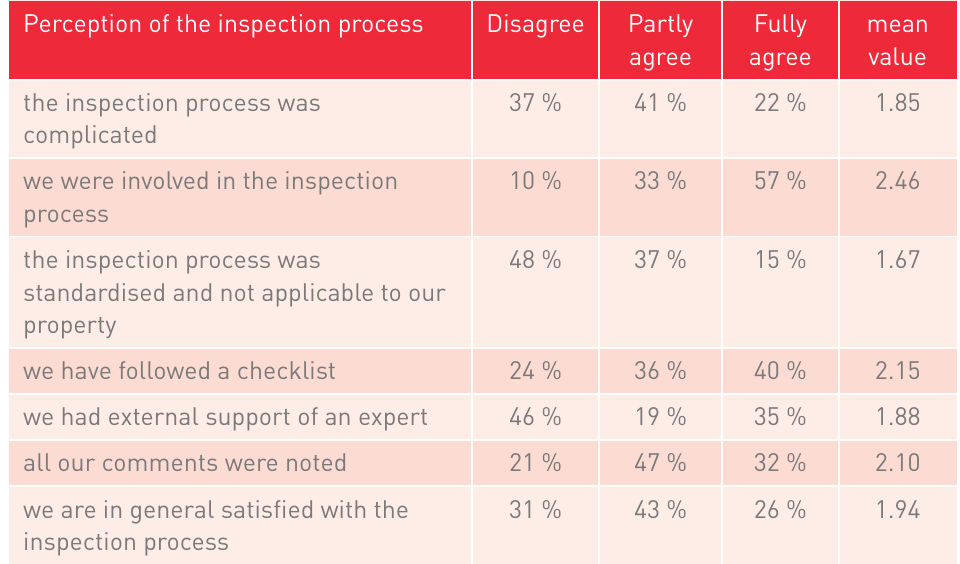
Perception of the inspection process.